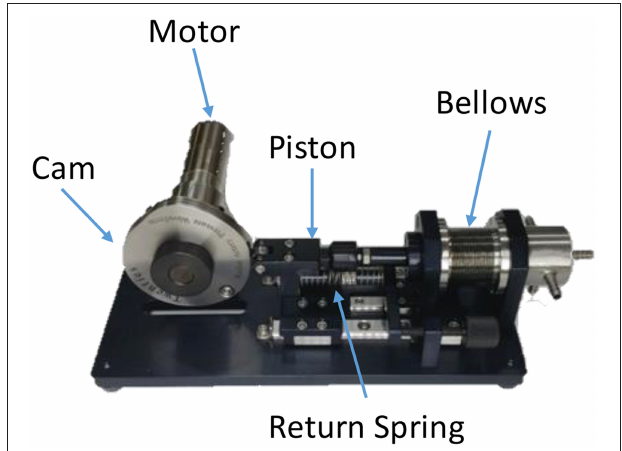
FIGURE 2 | Photo of the cam system used to generate human pulse